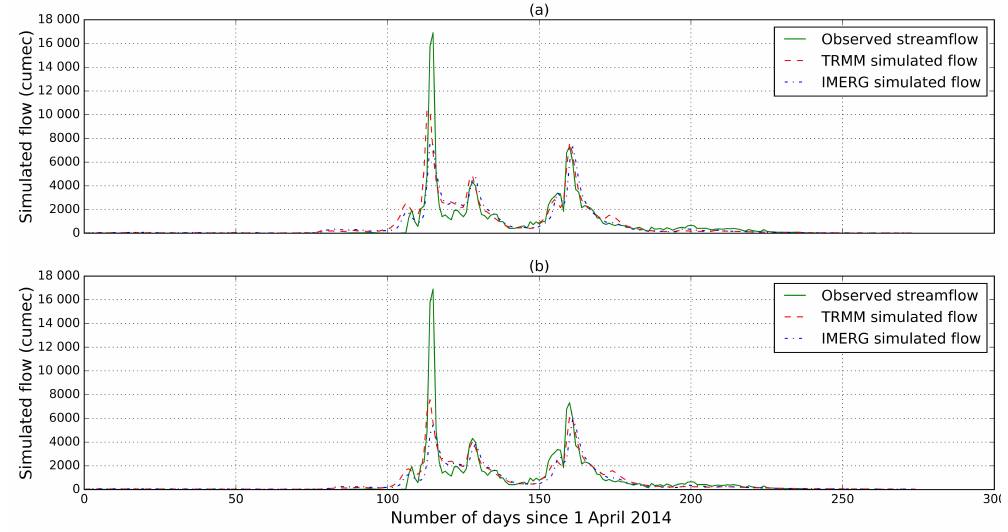
Figure 10. Hydrographs for TRMM and IMERG simulations (1 April–31 December 2014) with (a) IMD and (b) TRMM calibrated VIC model for the Wainganga